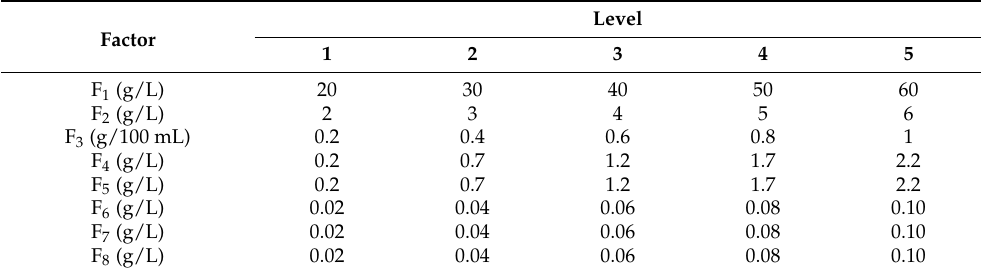
Table 1. The factors and levels of the orthogonal design for medium composition optimization.